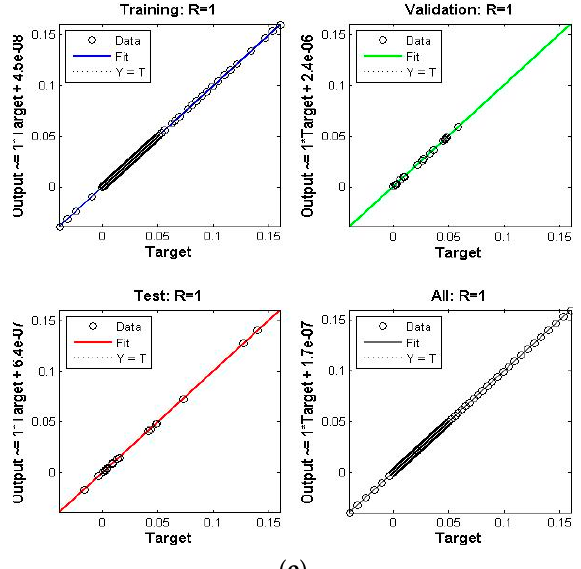
Figure 7. Scenario IV Case I of TD-PNFM. ( a ) MSE Results: Scenario IV Case I; ( b ) Transition state: Scenario IV Case I; ( c )